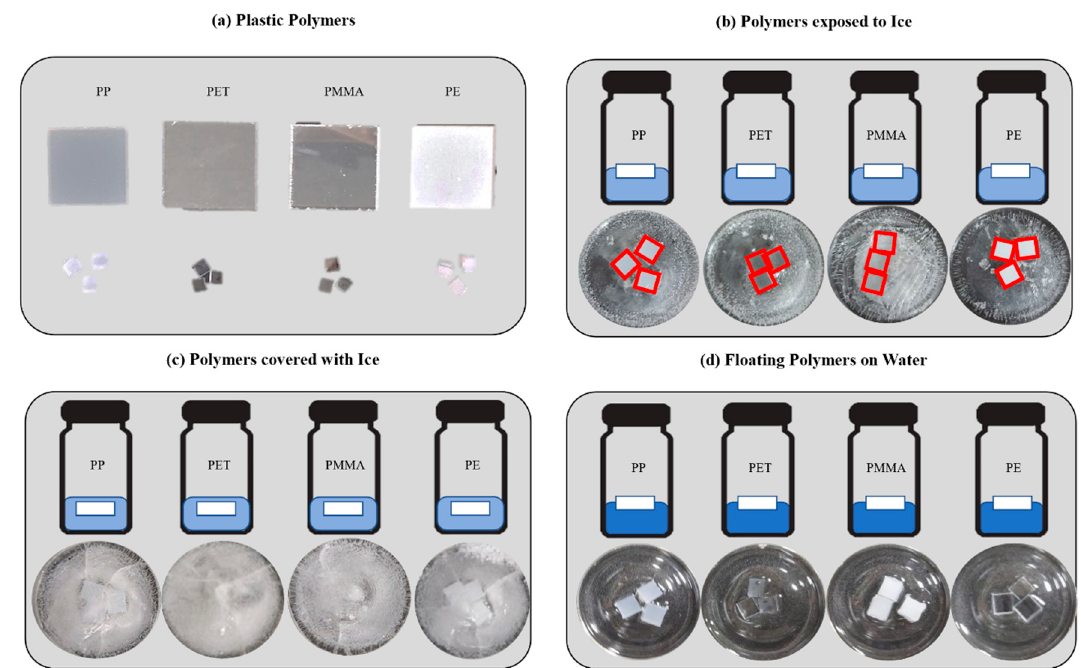
Figure 1. Schematic and pictures of sample materials. ( a ) Plastic polymers, ( b ) plastic polymers exposed to ice, ( c ) plastic polymers covered with ice, ( d ) floating plastic polymers in water.